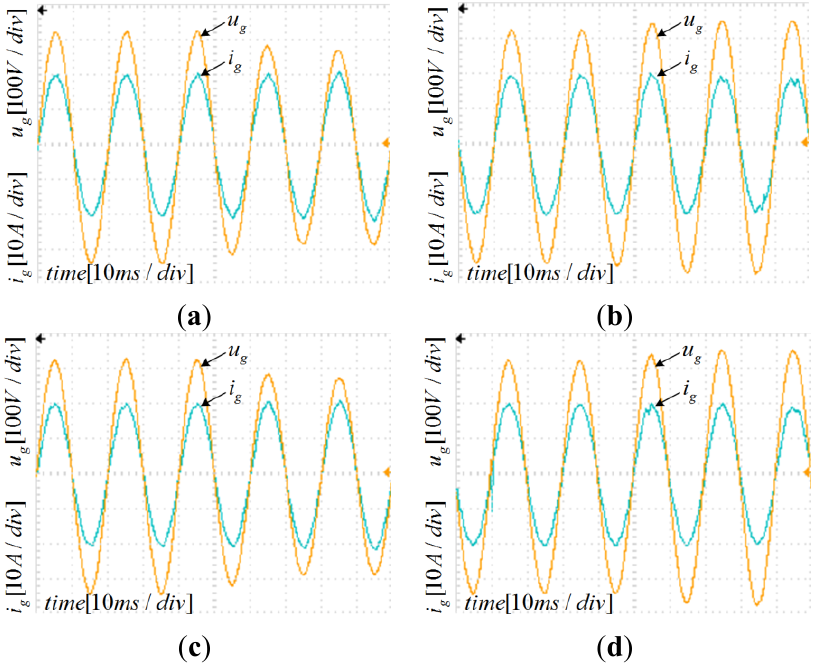
Figure 21. Grid voltage and injected current at full load with inductor L variation: 2 experimental results. ( a ) Inductor L increased by 150%: grid voltage sag; ( b ) inductor L 2 2 increased by 150%: grid voltage swell; ( c ) inductor L decreased by 20%: grid voltage sag; 2 ( b ) inductor L decreased by 20%: grid voltage 2